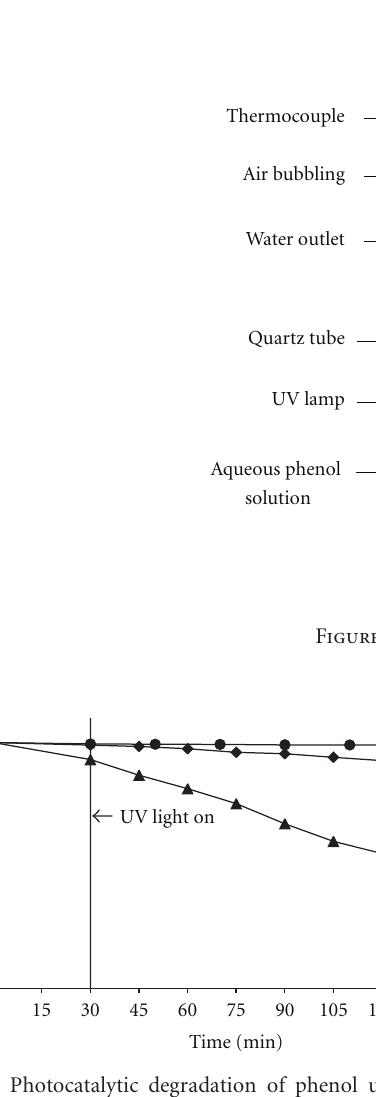
= in (cid:0) = UV irradiation in (cid:2)